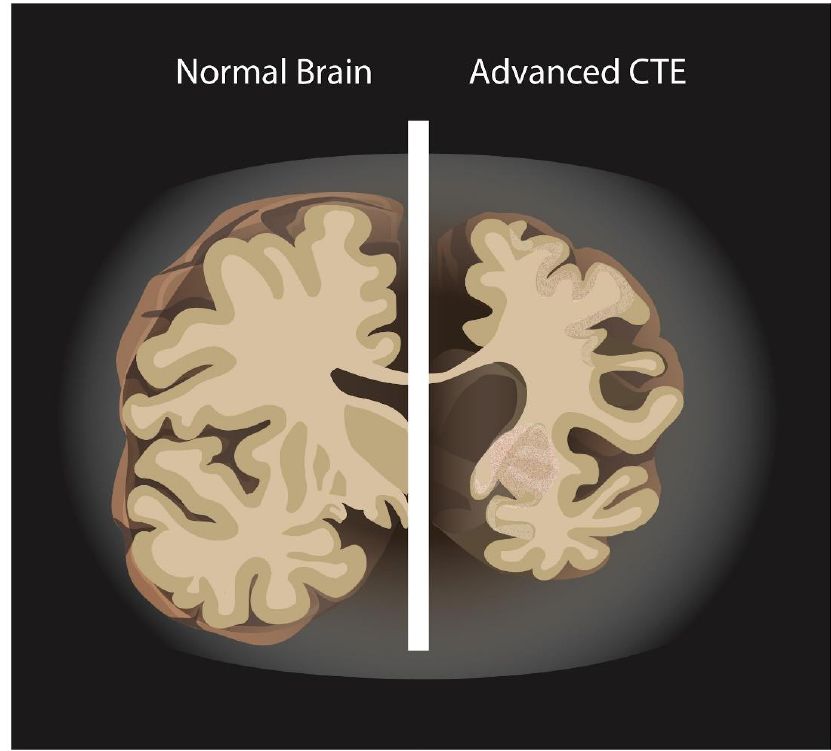
Figure 1. Normal brain vs. Chronic traumatic encephalopathy (CTE).